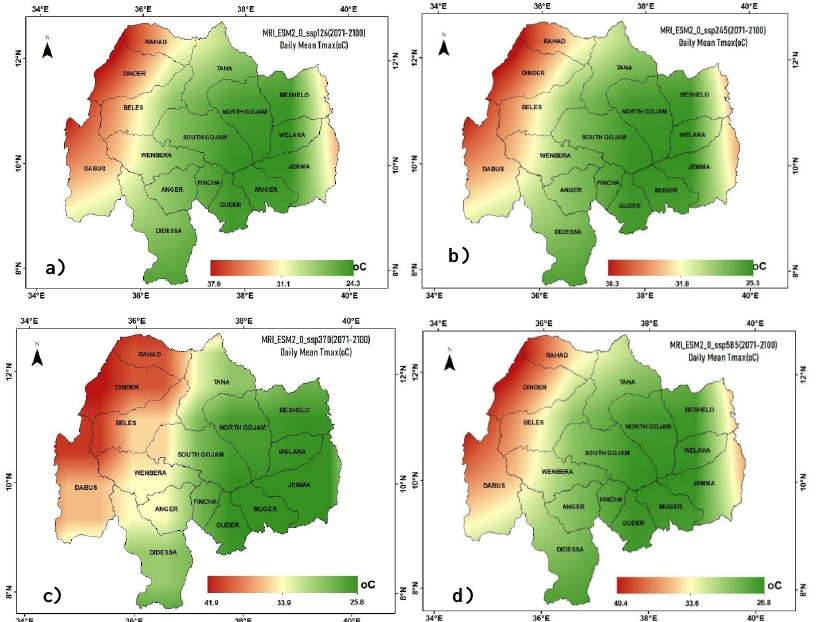
Figure A4. Square root quantile- quantile mapping of model Tmax (MIROC6, MIROC-ES2L, MRI-ESM2-0, and UKESM1-0-LL) versus ECMWF-ERA5 monthly observation.